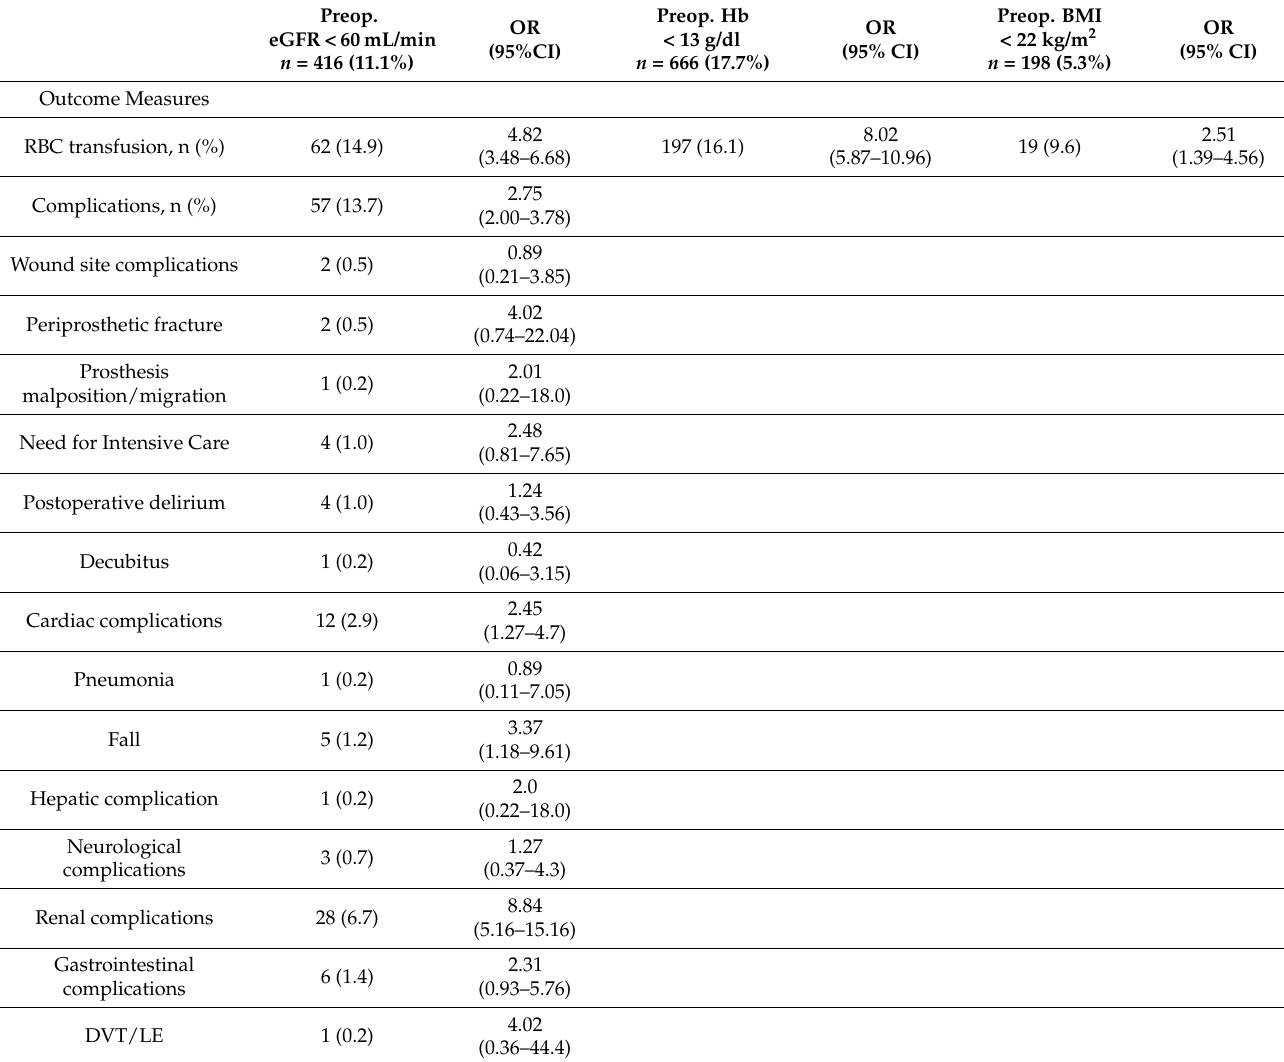
Table 3. Rates and risks of allogeneic red blood cell transfusions and complications in potentially modifiable high-risk